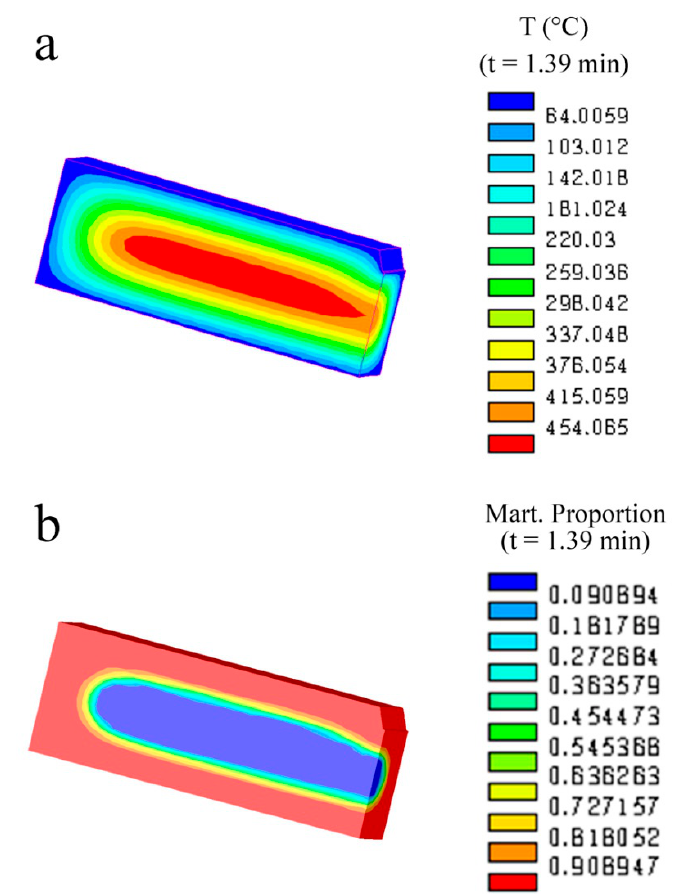
Figure 10. Calculated temperature ( a ) and martensite proportion ( b ) distribution at 1.39 min during cooling.